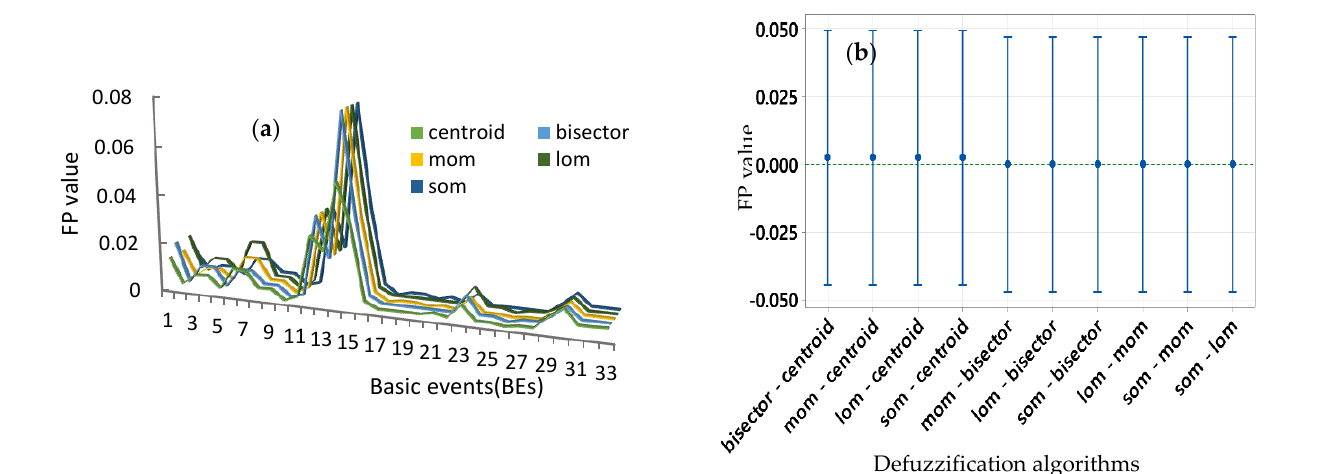
Figure 6. The results of FP for basic events considering the effects of defuzzification algorithms.